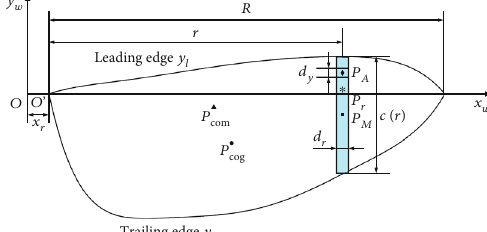
Figure 3: The plane pro fi le and the geometric parameters of the arti fi cial